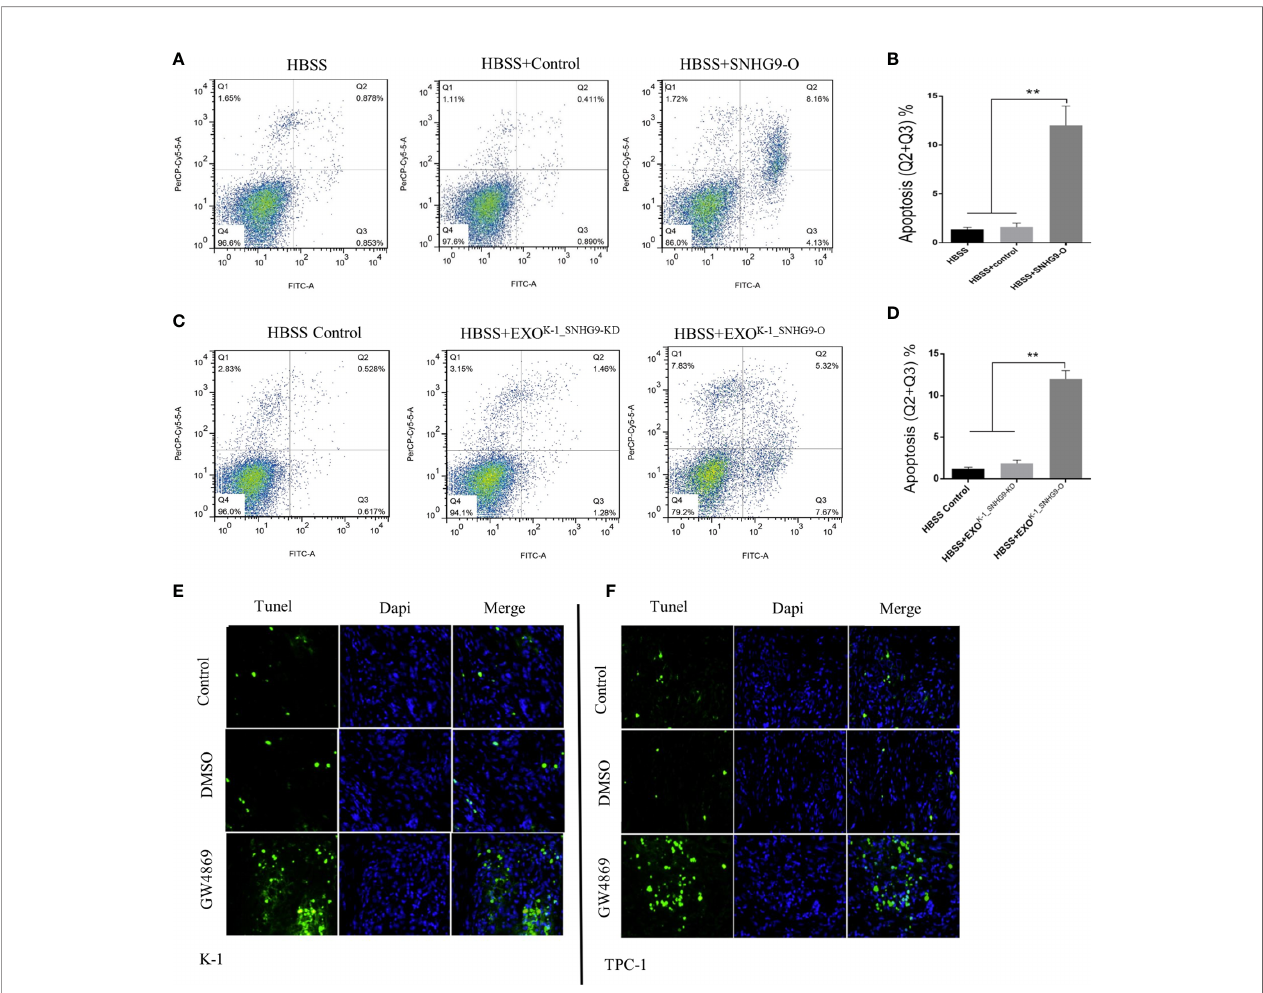
FIGURE 3 | SNHG9 promotes Nthy-ori-3 cell apoptosis through PTC exosomes. (A, B) Overexpressing SNHG9 in HBSS treated Nthy-ori-3 cells could promote cell apoptosis detected by fl ow cytometry. (C, D) K-1 SNHG9-O/ K-1 SNHG9-KD exosomes could promote/inhibit Nthy-ori-3 cells apoptosis detected by fl ow cytometry. (E, F) The impact of K-1 SNHG9-O/ TPC-1 SNHG9-KD exosomes on Nthy-ori-3 cell apoptosis was decreased after PTC cell exosomes secretion was inhibited by GW4869 by Tunel staining assay. **P < 0.01, data were pooled from three independent experiments. PTC, papillary thyroid cancer. KD, knock down; O, overexpression; HBSS, Hank ’ s balanced salt